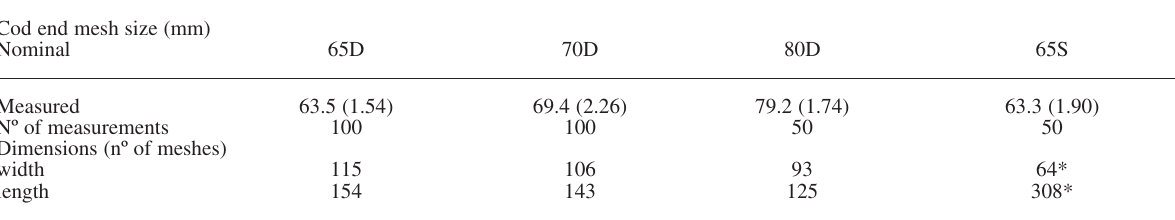
T ABLE 1. – Details of cod ends. Standard errors are in brackets; D, diamond mesh; S, square